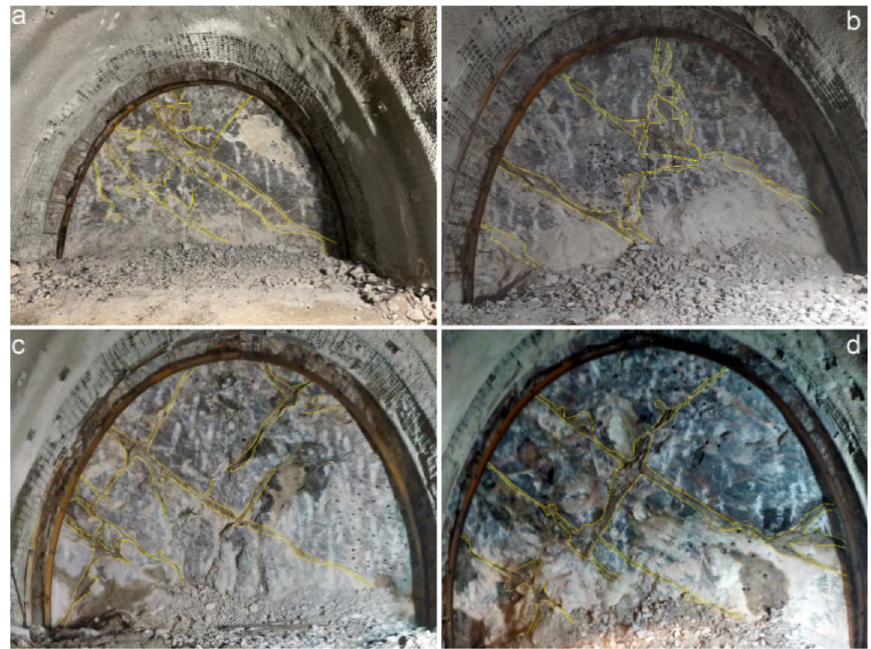
Fig. 13 Injection dispersions encountered during tunnel excavation (a-Km:54 c-Km: 54 004.25, d-Km:53 990.75 excavation face, injection are the areas within the yellow + +